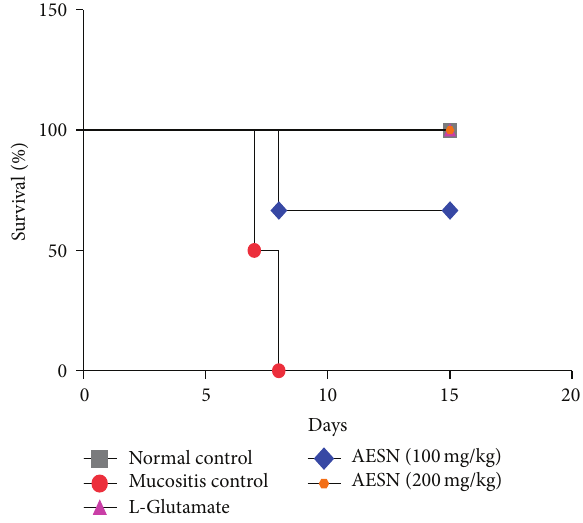
Figure 10: Mortality rate in methotrexate induced oral mucositis. 0% mortality was observed in normal control and L-glutamate groups, whereas in mucositis control group 100% mortality was observed on 8th day. In AESN (100mg/kg and 200 mg/kg) the mortality rate was found to be 33% and 0%, respectively, at the end of study